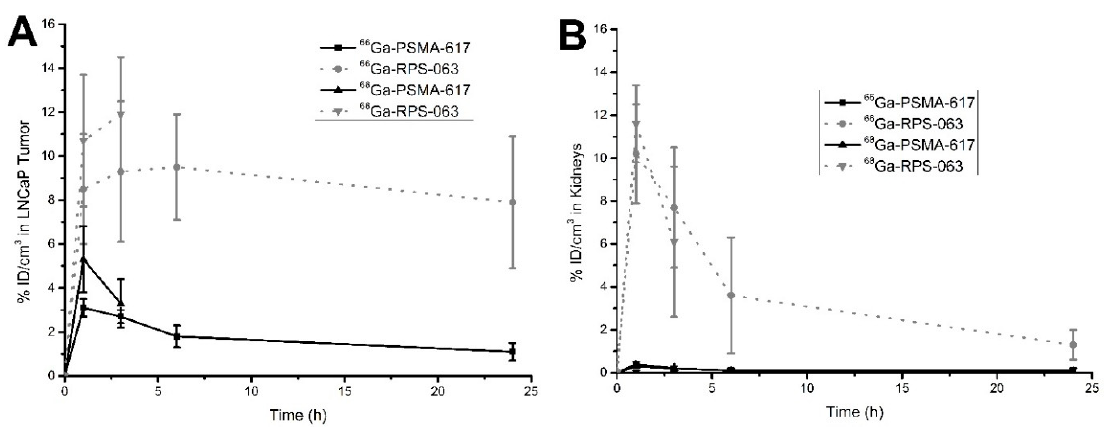
Figure 4. Time-activity curves of [ 66/68 Ga]PSMA-617 and [ 66/68 Ga]RPS-063 in LNCaP xenograft tumors ( A ) and kidneys ( B ). The activities were derived from µ PET/CT images by defining a VOI and comparing the corresponding counts to a standard of known activity.